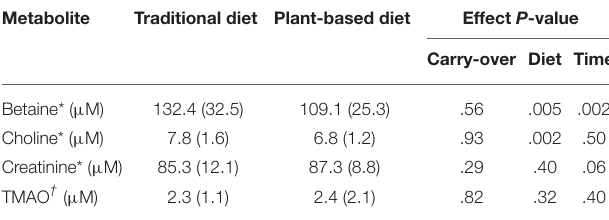
TABLE 4 | Laboratory results and P -values for AB/BA analysis of plasma levels of betaine, choline, creatinine, and trimethylamine- N -oxide (TMAO) in 16 dogs after 4 weeks on a traditional diet or a plant-based